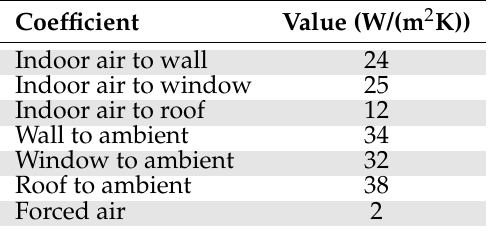
Table A2. Convective heat transfer coefficients used for the thermodynamic building